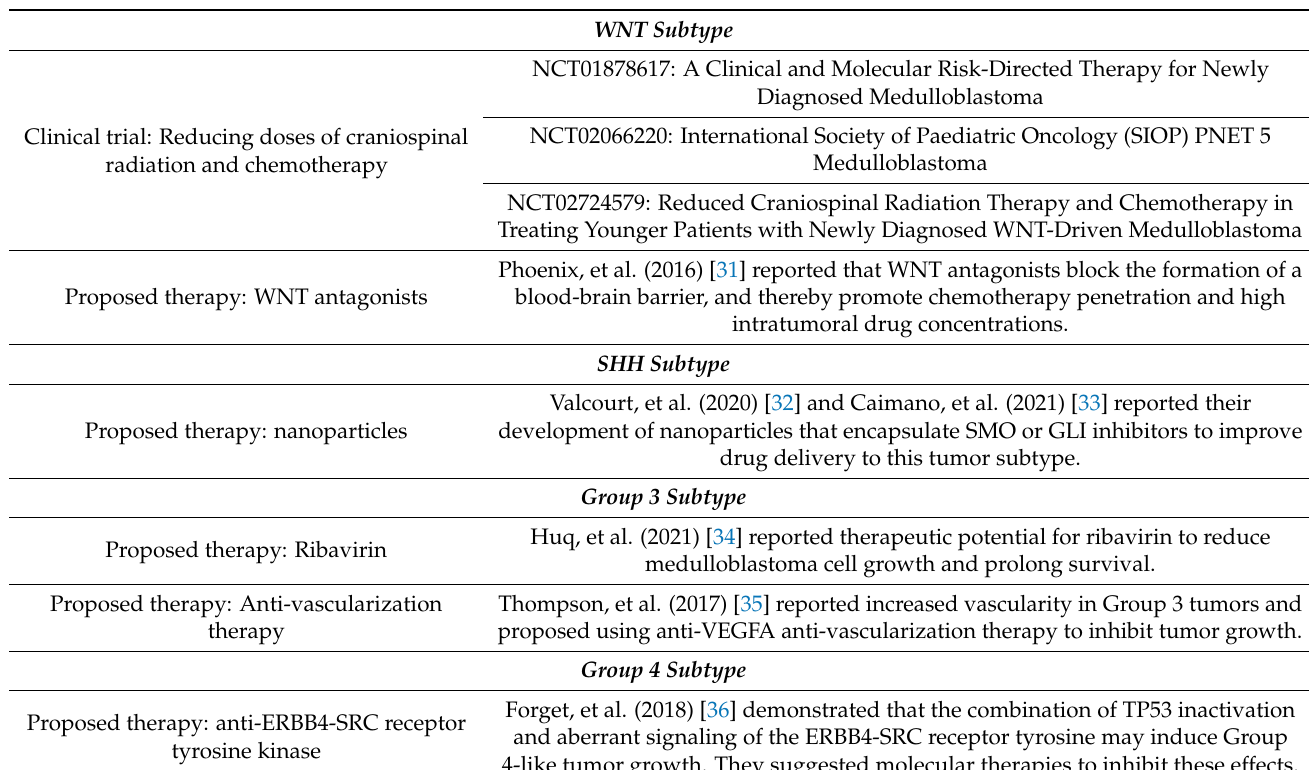
Table 1. Clinical trials and therapies in development for the four pediatric medulloblastoma